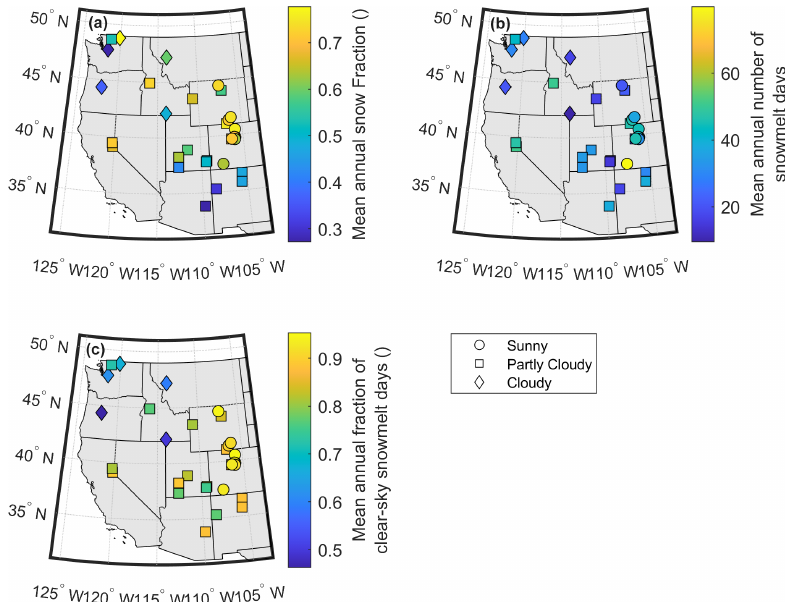
Figure A3. (a) CAMELS mean annual snow fraction (snowfall / precipitation), (b) mean annual number of snowmelt days between 1 De- cember and 1 August (calculated as the days with a correlation between hourly solar radiation and lagged streamflow greater than 0.8), and (c) mean annual fraction of clear-sky snowmelt days, calculated as the number of snowmelt days with clear-sky conditions as a fraction of total snowmelt days. A clear-sky snowmelt day is defined as having more than 80% of the potential clear-sky solar radiation. Symbols (circle, square, and diamond) represent the mean annual percentage of clear-sky snowmelt days, where sunny sites have > 90% clear-sky snowmelt days, partly cloudy have between 70% and 90%, and cloudy have < 70.